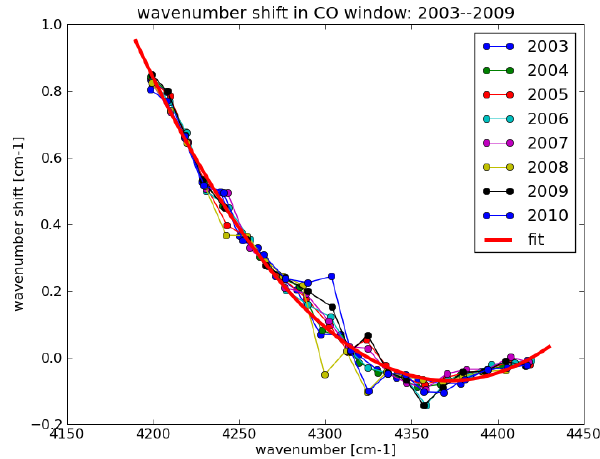
Fig. 9. Spectral correction to the on-ground pixel-to-wavelength relationship. negatively biased VCD distributions (note the different color bars) and unrealistic re- gional patterns (e.g. Himalayas).